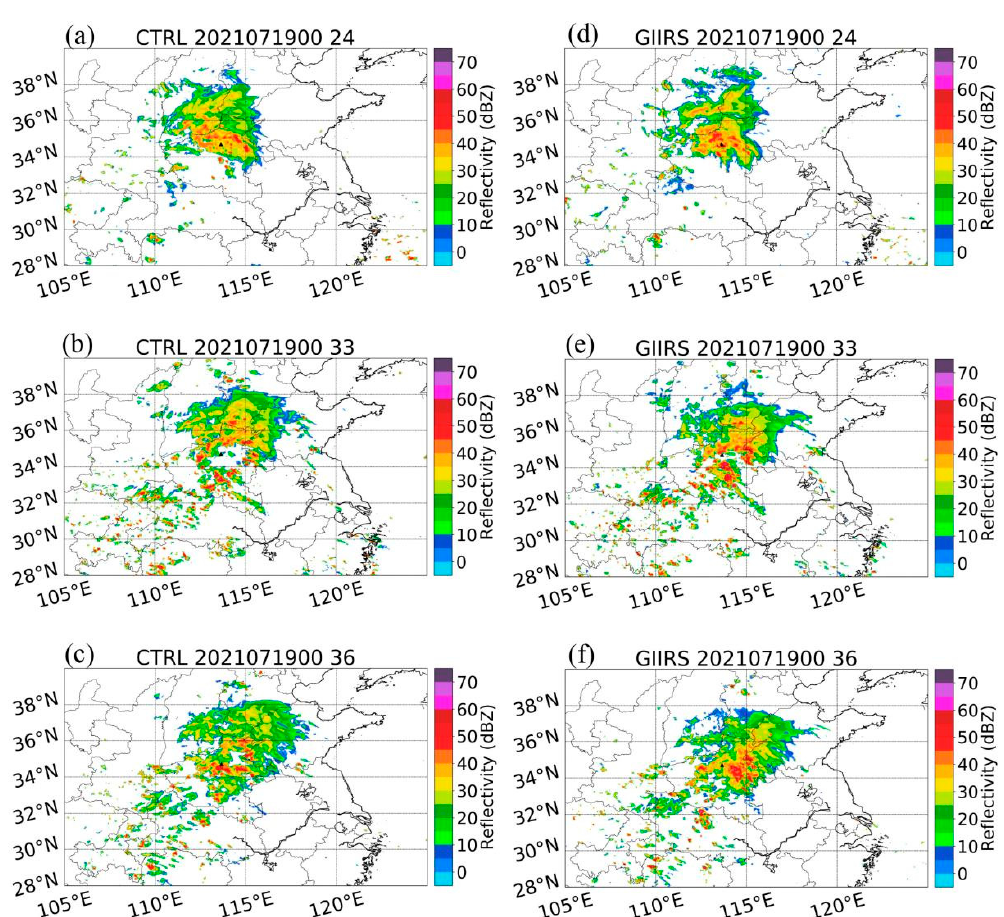
Figure 9. Radar composite reflectivity (dBZ) of the CTRL experiment at 0000 UTC ( a ), 0900 UTC ( b ), and 1200 UTC ( c ) on 20 July 2021 (24-h, 33-h and 36-hourour forecasts initialized from 0000 UTC on 19 July 2021). ( d – f ) are the same as ( a – c ), but for the GIIRS experiment. The black triangle indicates Zhengzhou Station (113.66°E, 34.71°N).